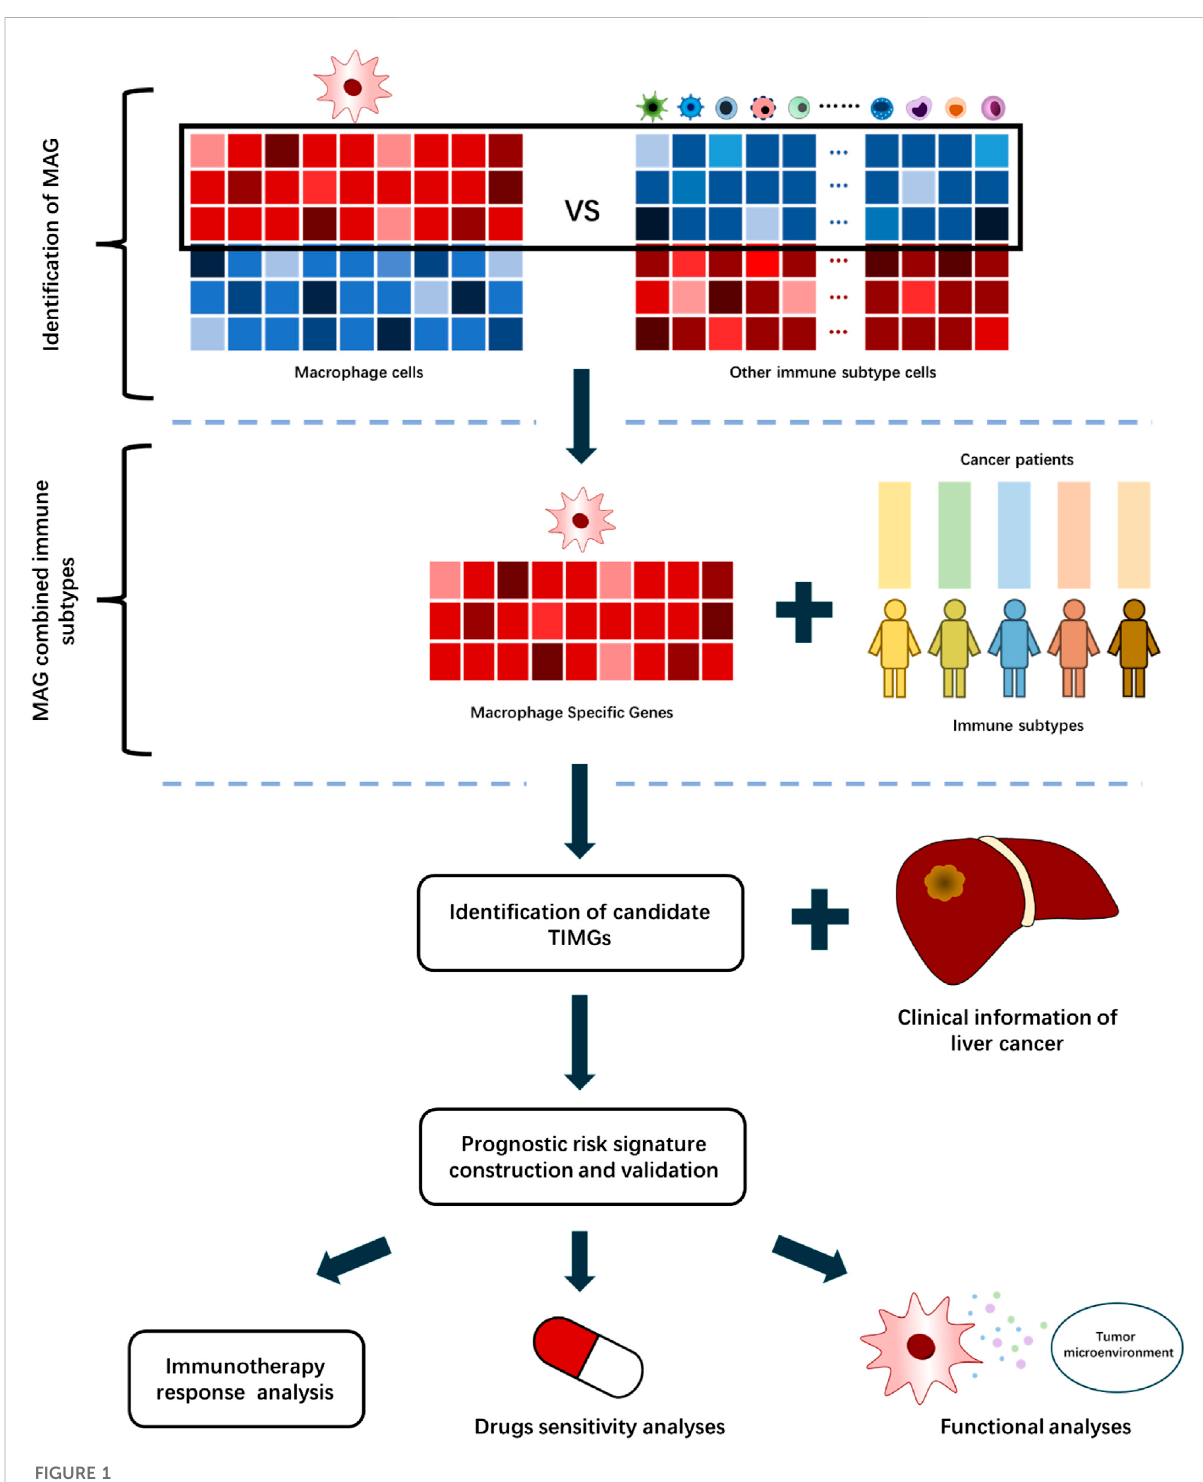
FIGURE 1 Work fl ow of TIMSig generation and